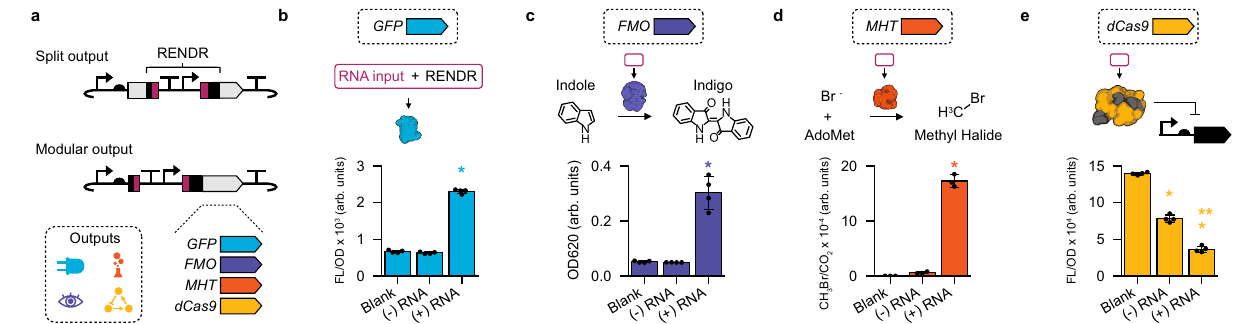
Fig.4|AmodularRENDRdesignallowsforinterchangeableproteinoutputsin response to RNA inputs. a Schematic of a non-modular output design that depends upon gene-speci fi c splits in the CDS (top) and a schematic of a modular outputdesignthatusesRENDRtoseparatetheRBSfromanyCDSoutput(bottom). The modular design facilitates the simple exchange of different outputs that pro- duce fl uorescence, gaseous, colorimetric, and regulatory outputs. b Fluorescent characterization (measured in units of fl uorescence [FL]/optical density [OD] at 600nm) from RENDR using an sfGFP output. c Characterization of indigo pro- duction (measured in optical density [OD] at 620nm) from RENDR using a fl avin monooxygenase (FMO) output. d Characterization of methyl-bromine gas pro- duction (measured in CH 3 Br/CO 2 ) from RENDR using a methyl-halide transferase (MHT)output. e CharacterizationofadCas9proteinoutputfromRENDRmeasured using an sfGFP-repressing CRISPR interference assay in cells containing a geno- mically integrated sfGFP expression cassette. For ( b – e ), characterization was